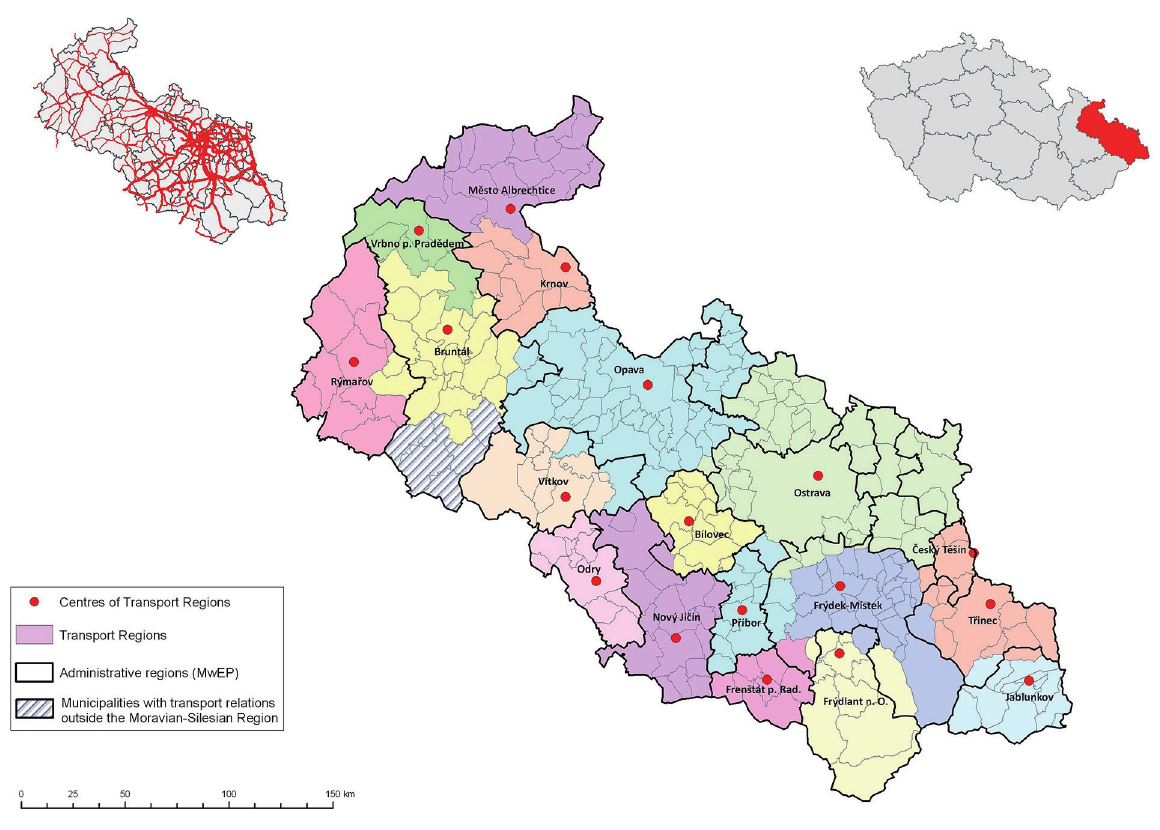
Fig. 3. Transport regionalisation of the Moravian-Silesian Region (2010) Source: RTC 2010, own